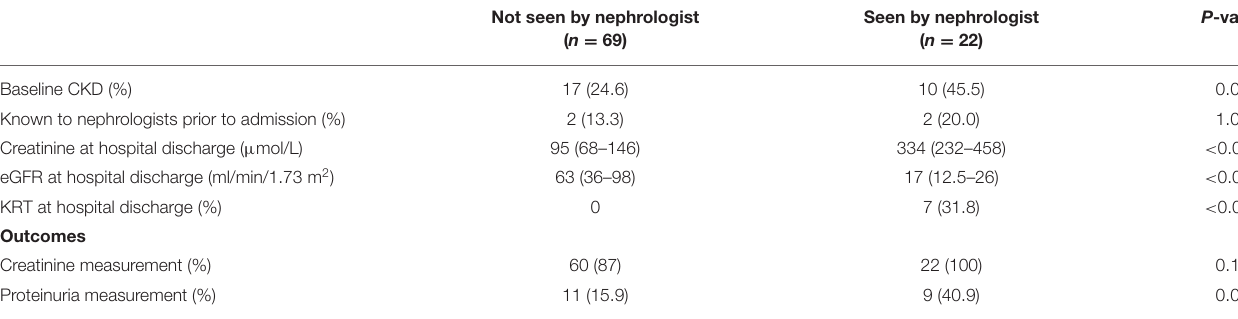
TABLE 4 | Characteristics and outcomes by nephrology vs. no-nephrology follow-up in following 12 months after hospital discharge.